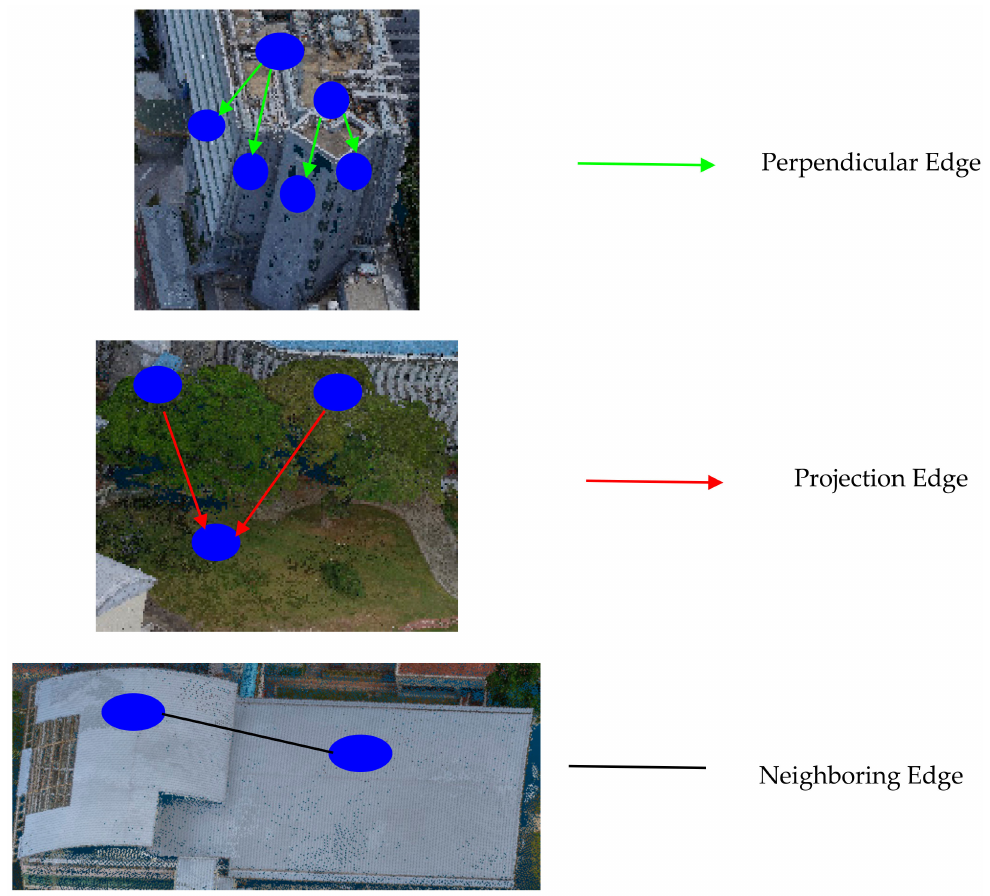
Figure 2. An illustration of the topological relations in the constructed graph. Circles and lines in each figure represent nodes and edges in the graph,